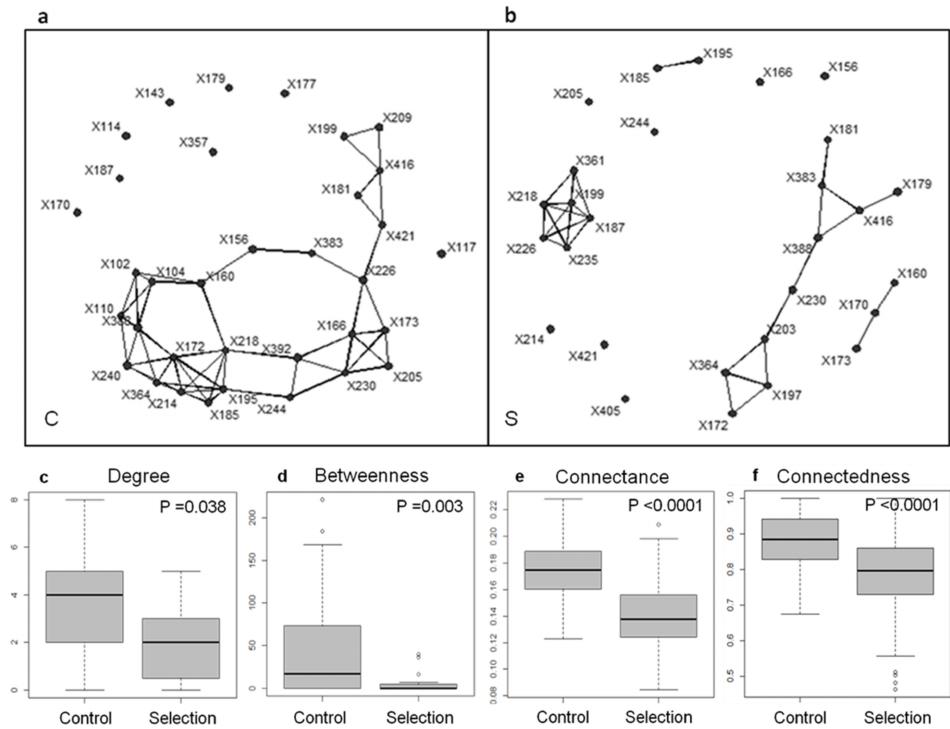
Figure 2. An example of a network-based analysis of microbiome selection (from [40]). The co- occurrence matrices of the T-RFLP-defined genetic units present after 21 generations were used to build interaction networks for ( a ) the control (C) and ( b ) the selection treatment for low CO 2 emission (S). When two dots are connected by lines, it means that the abundances of the genetic units were significantly correlated (Spearman correlation coefficient; N = 6; p < 0.05). The interaction networks were used to calculate several network indices ( c – f ) as follows. The average degree ( c ) is the average number of interactions engaged in by one genetic unit (equal to 0 for an unconnected unit), providing an estimate of network complexity. The average betweenness ( d ) is the average number of shorter chains going through one node, which can signal the presence of keystone species in the network. The connectance ( e ) is the proportion of possible links between species that are actually realized. The connectedness ( f ) is the probability that at least one chain exists between any pair of units, which quantifies all the direct and indirect interactions within the network. The networks were bootstrapped (200 random samples from each group’s pool of genetic units) to determine ( e ) average connectance and ( f ) average connectedness. The values of these indices were compared for the control and selection treatment using Wilcoxon rank-sum tests (employing a continuity correction for non-parametric